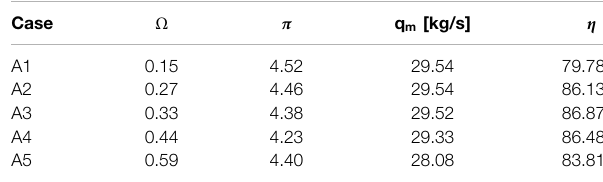
TABLE 1 | Overall performance parameters of Case A1 – Case